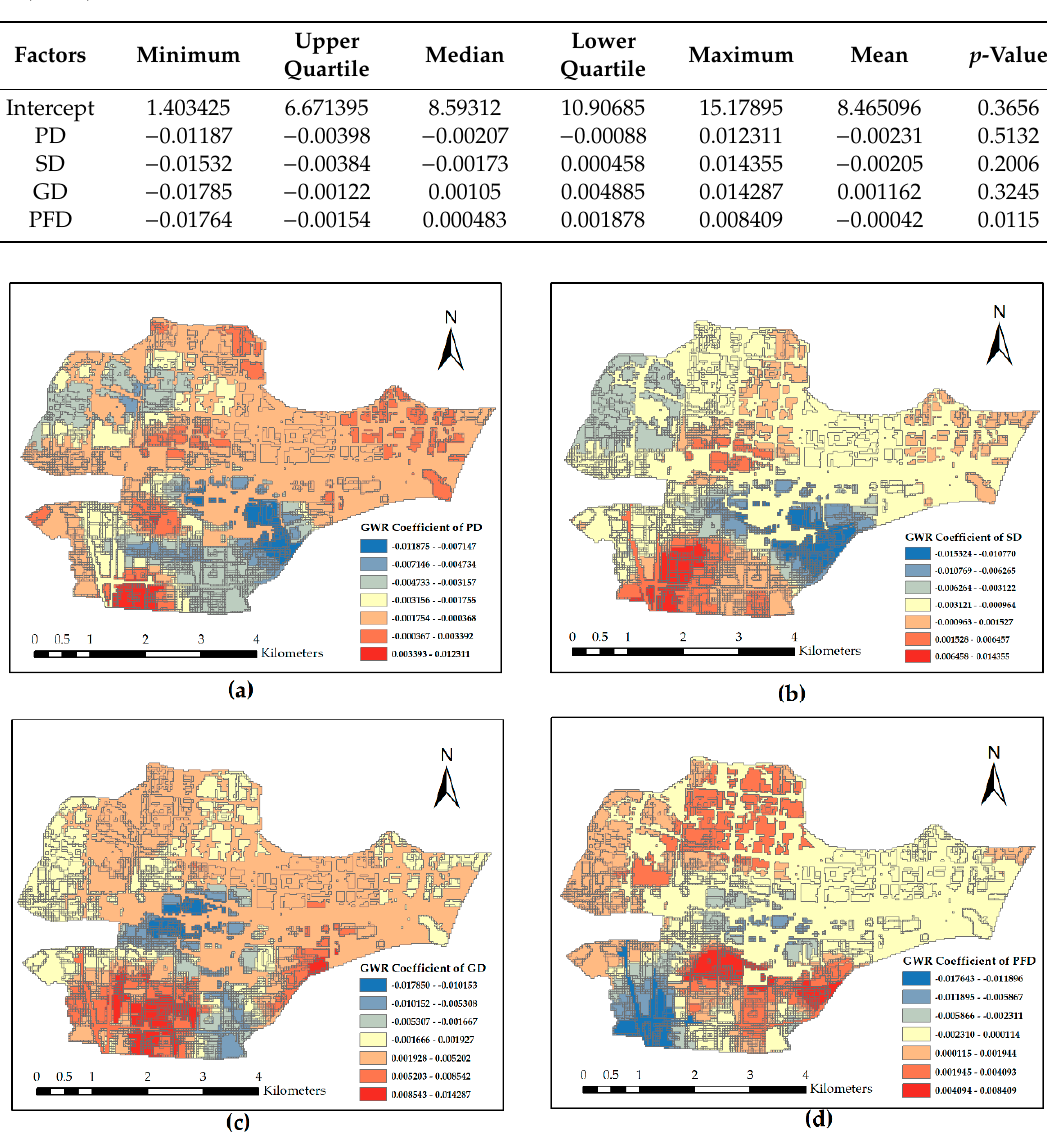
Figure 8. GWR coe ffi cient distribution of four types distances. ( a ) GWR coe ffi cient of distance to park, Figure 8. GWR coefficient distribution of four types distances. ( a ) GWR coefficient of distance to park, (PD); ( b ) GWR coe ffi cient of distance to square (SD); ( c ) GWR coe ffi cient of distance to green land (GD); (PD); ( b ) GWR coefficient of distance to square (SD); ( c ) GWR coefficient of distance to green land ( d ) GWR coe ffi cient of distance to public facilities (GD); ( d ) GWR coefficient of distance to public facilities (PFD).